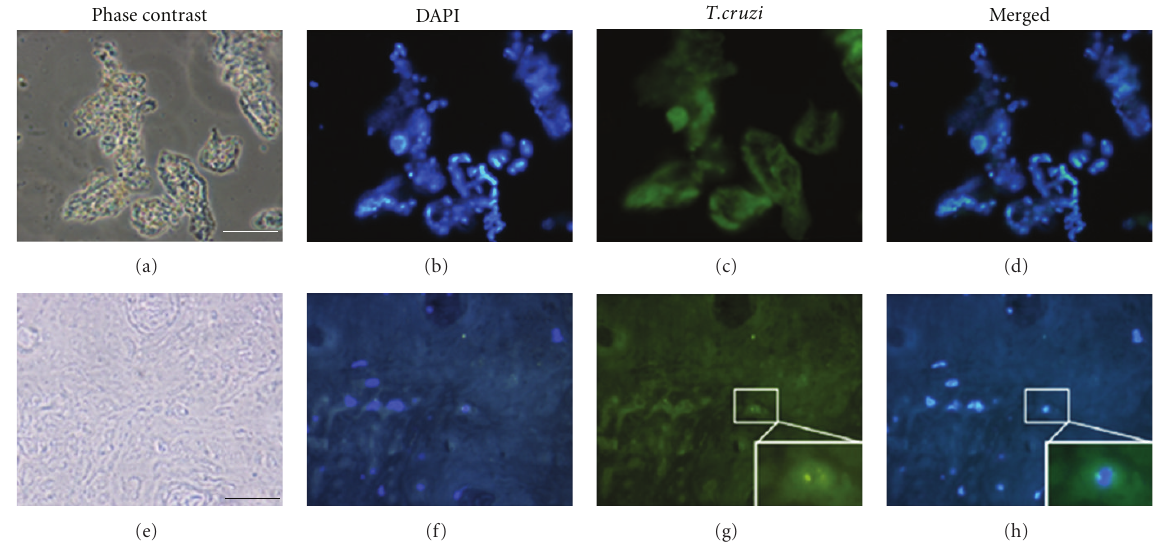
Figure 2: Detection of T. cruzi in human placental chorionic villi from infected mothers . The presence of parasites in villous stroma of chorionic villi from T. cruzi infected placentas was shown by immunofluorescence, detected using mAb 25 antibodies. In (a–d), noninfected chorionic villi (controls) are shown. Panels (a–d) and (e–h) show images of the same fields. Panels (a) and (e): phase contrast; (b) and (f): nuclear staining with DAPI; (c) and (g): detection of the parasite by immunofluorescence; (d) and (h): merged images of (b-c) and (f-g), respectively. Inserts show an amplified region of the detection of the parasite by immunofluorescence (g-h). Bar scale (a–d): 50 μ m; (e–h): 25 μ m.